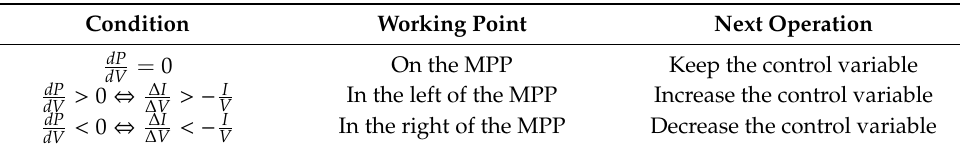
Table 1. Summary of the power behavior with the incremental conductance maximum power point tracker (MPPT) control